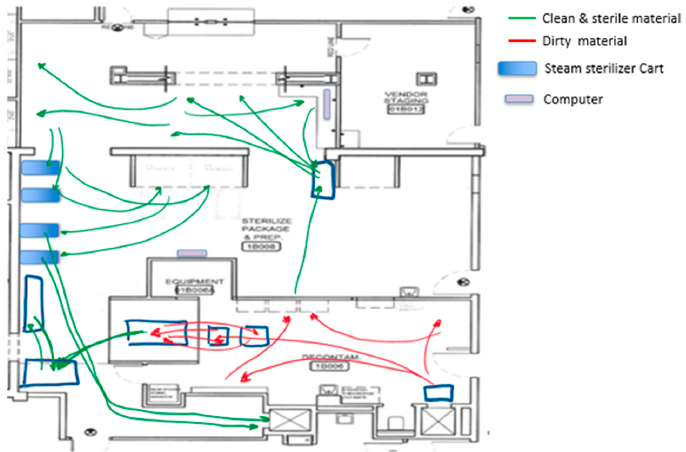
Figure 14. Spaghetti diagram after all the changes were implemented.